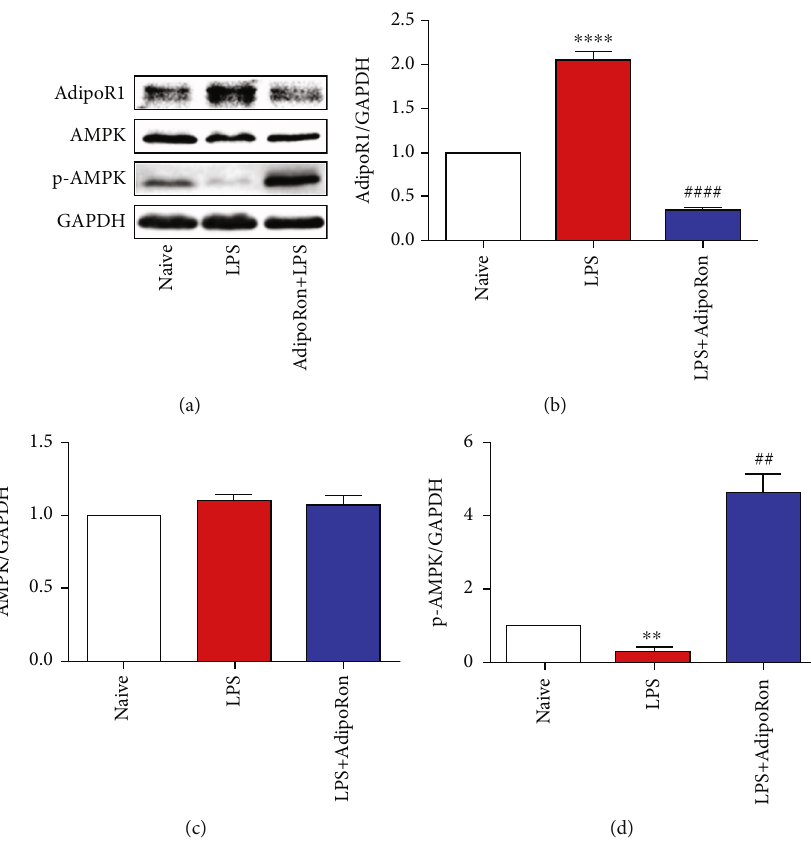
Figure 5: AdipoRon regulated the AdipoR1/AMPK pathway in LPS-treated BV2 cells. (a – d) Representative blots and quanti fi cation of AdipoR1, AMPK, and p-AMPK in BV2 cells in the Naive, LPS, and LPS+AdipoRon groups. Data were presented as mean ± SEM ( n = 3 ). ∗∗ p < 0 : 01 and ∗∗∗∗ p < 0 : 0001 vs. Naive and ## p < 0 : 01 and #### p < 0 : 0001 vs.